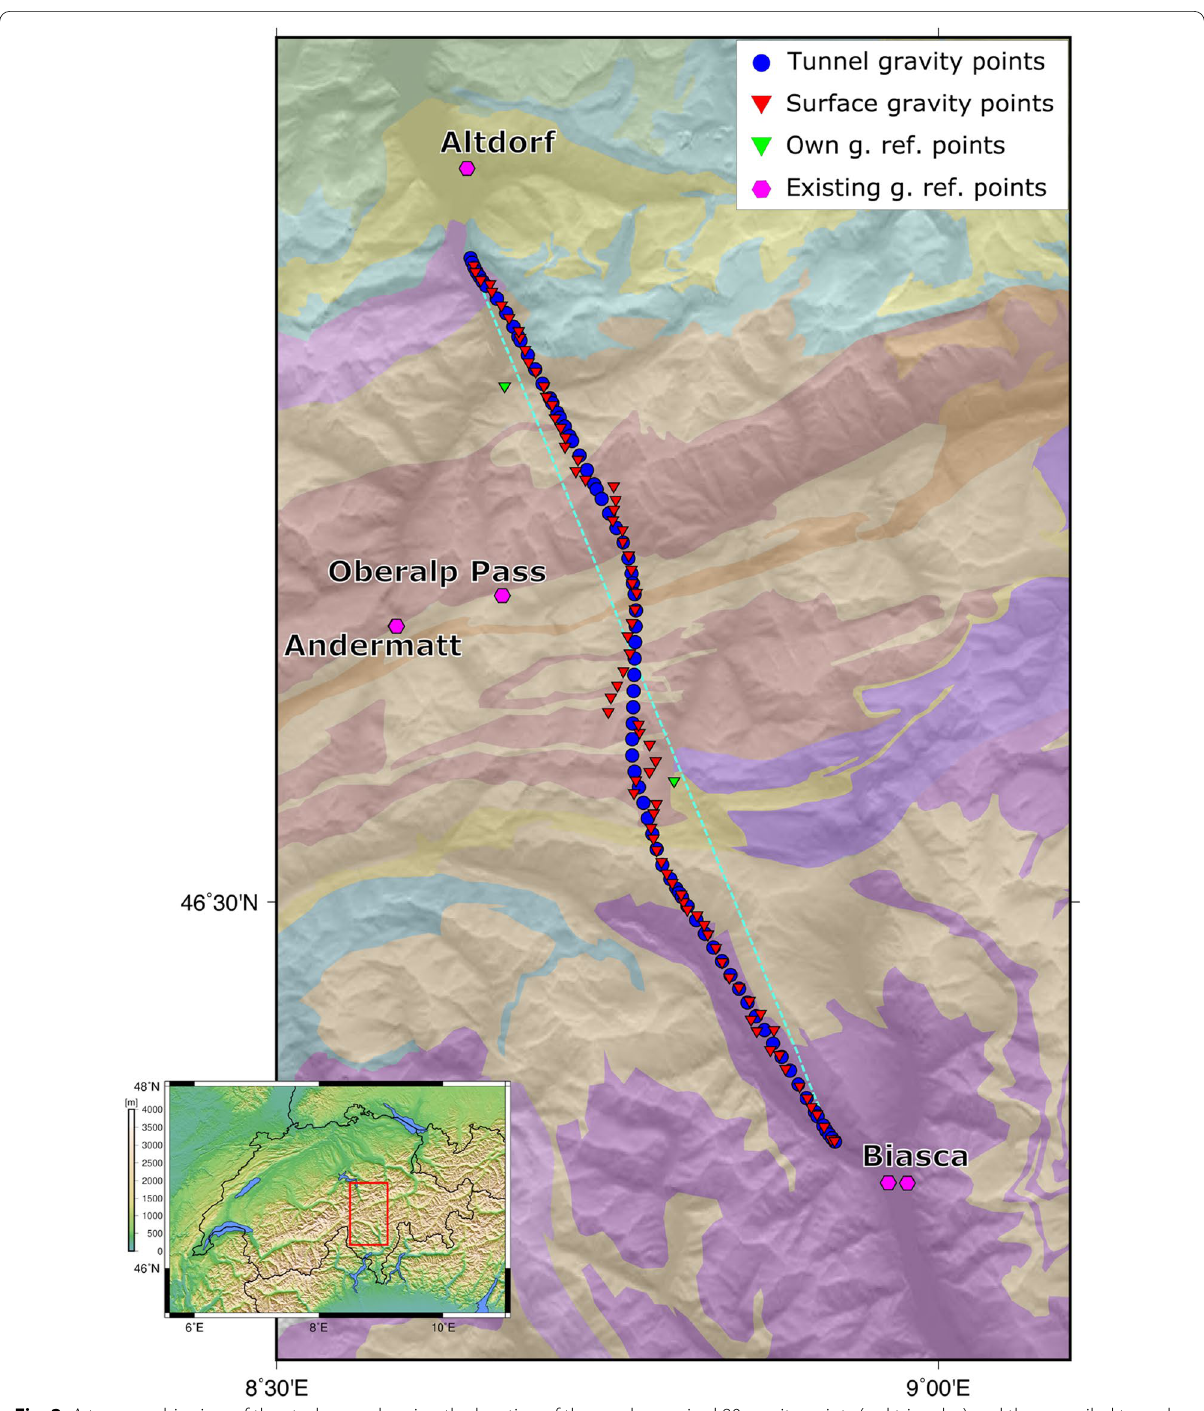
Fig. 2 A topographic view of the study area showing the location of the newly acquired 80 gravity points (red triangles) and the compiled tunnel gravity data points (77 points, blue circles). The green triangles represent our newly established relative reference points, which we tied to existing gravity reference points (magenta hexagons) and used to open and close daily measurement loops during the campaigns. The cyan dashed line represents the 2D model reference line, onto which both the geological model units and the gravity measurements are projected for comparison between synthetics and observations using 2D forward modelling. The background colours represent the mapped geological unit geometries at the surface; the geological units are simplified from and freely accessible at https:// map. geo. admin. ch/. The inset in the lower left corner indicates the location of the study area (red box) in Switzerland in topographic